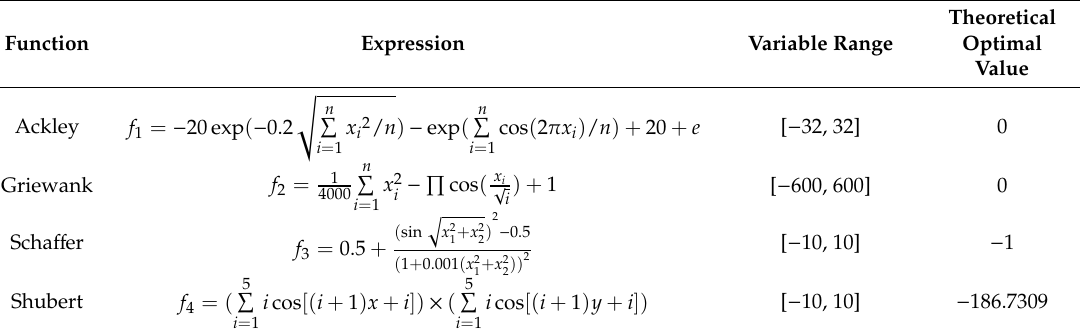
Table 1. Classic test function experimental parameters.